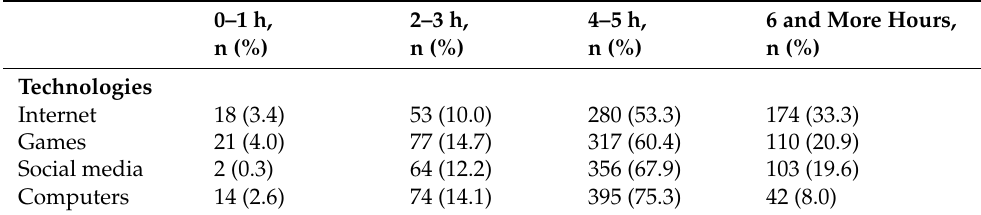
Table 5. Recurrent use of technology (Hours) (n = 525).